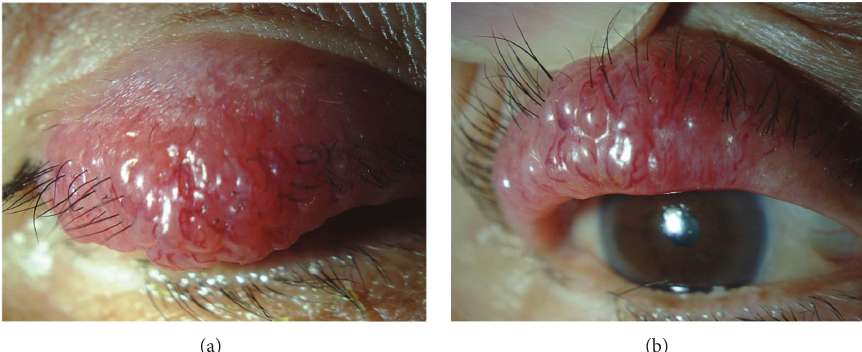
Figure 3: Clinical appearance of the right upper eyelid tumor. The painless, reddish, papillary, and solid 30 × 15 mm size nodule was observed in the right upper eyelid.